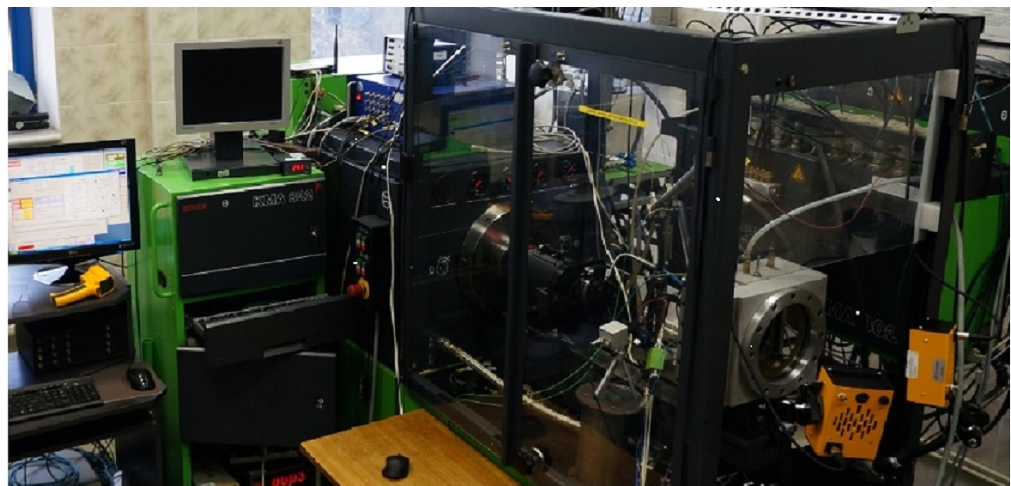
Figure 1. Workstation for visualisation of fuel injection process [53].